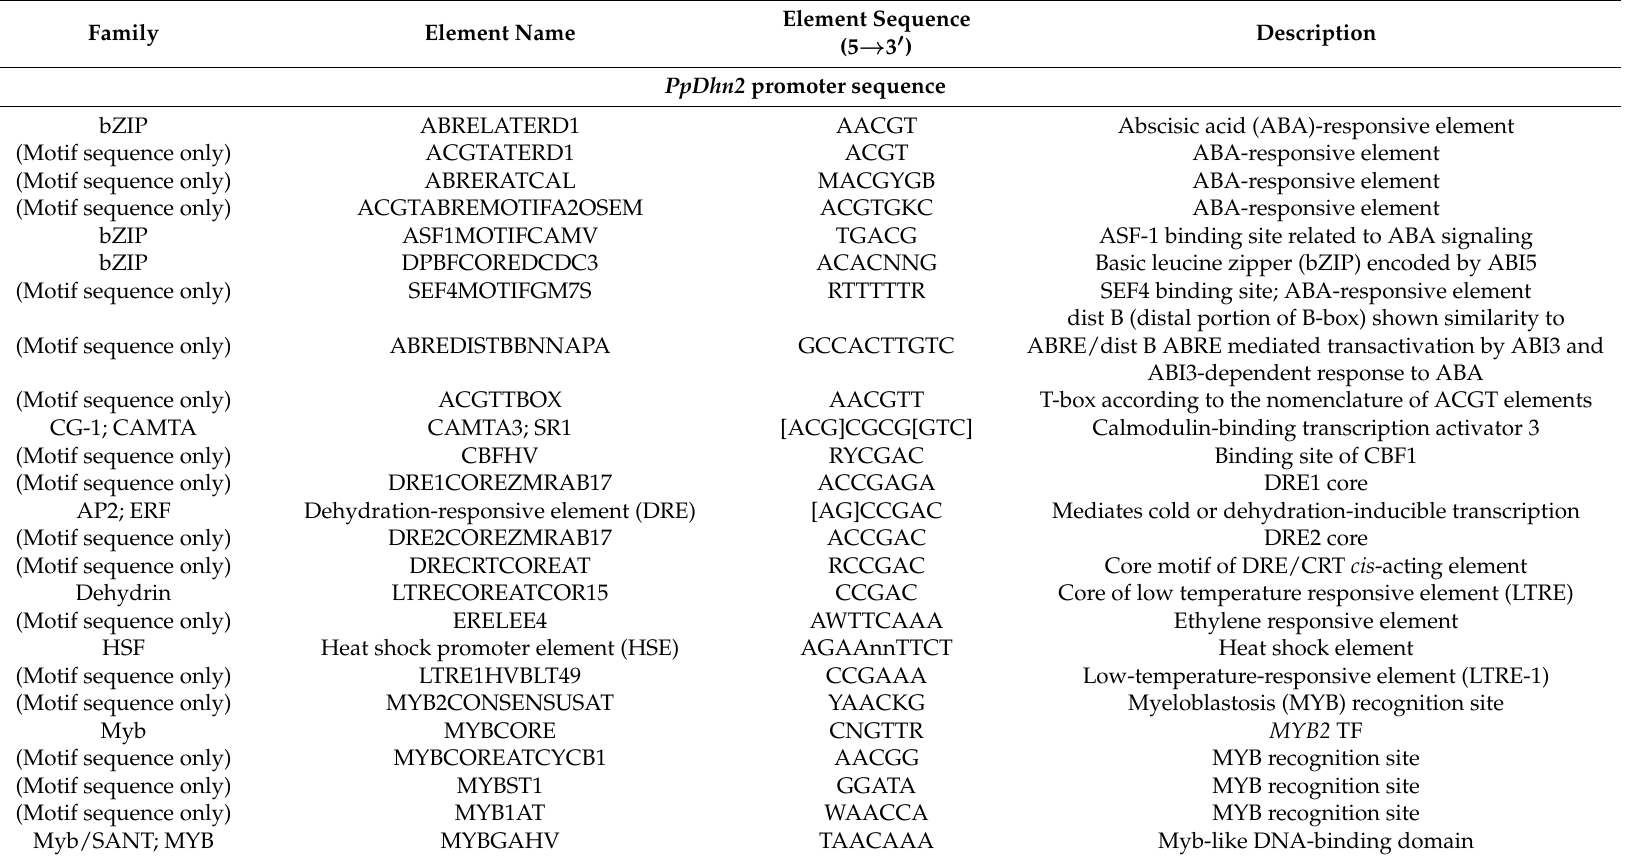
Table 2. Description of drought-related cis-regulatory elements (CREs) revealed in the promoter region of PpDhn2 and DREB2B